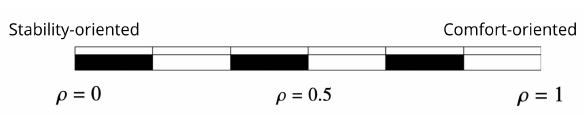
Figure 5. Scheduling variable